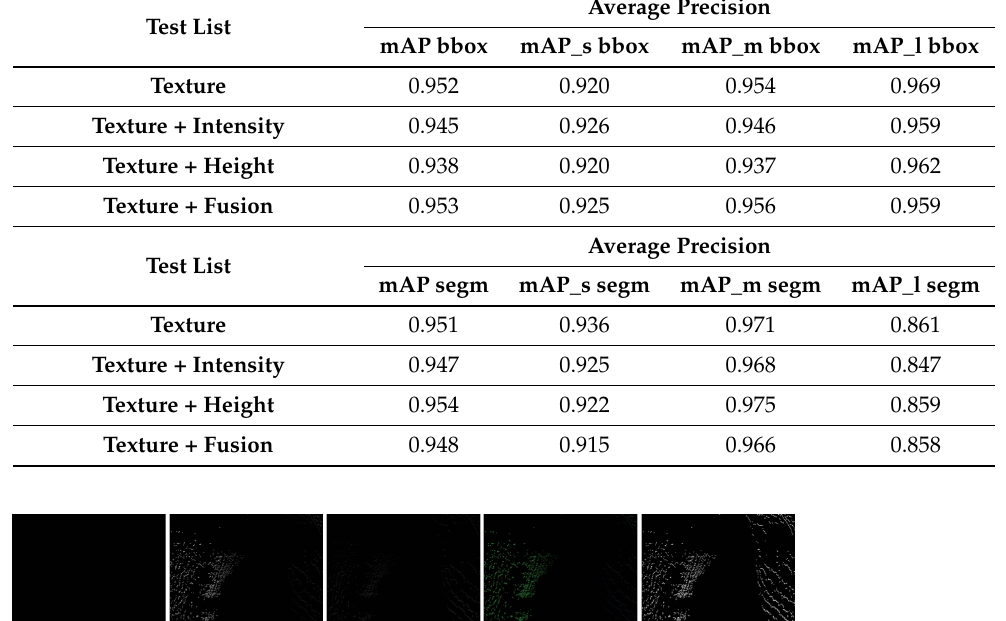
Table 2. Verification set test results.